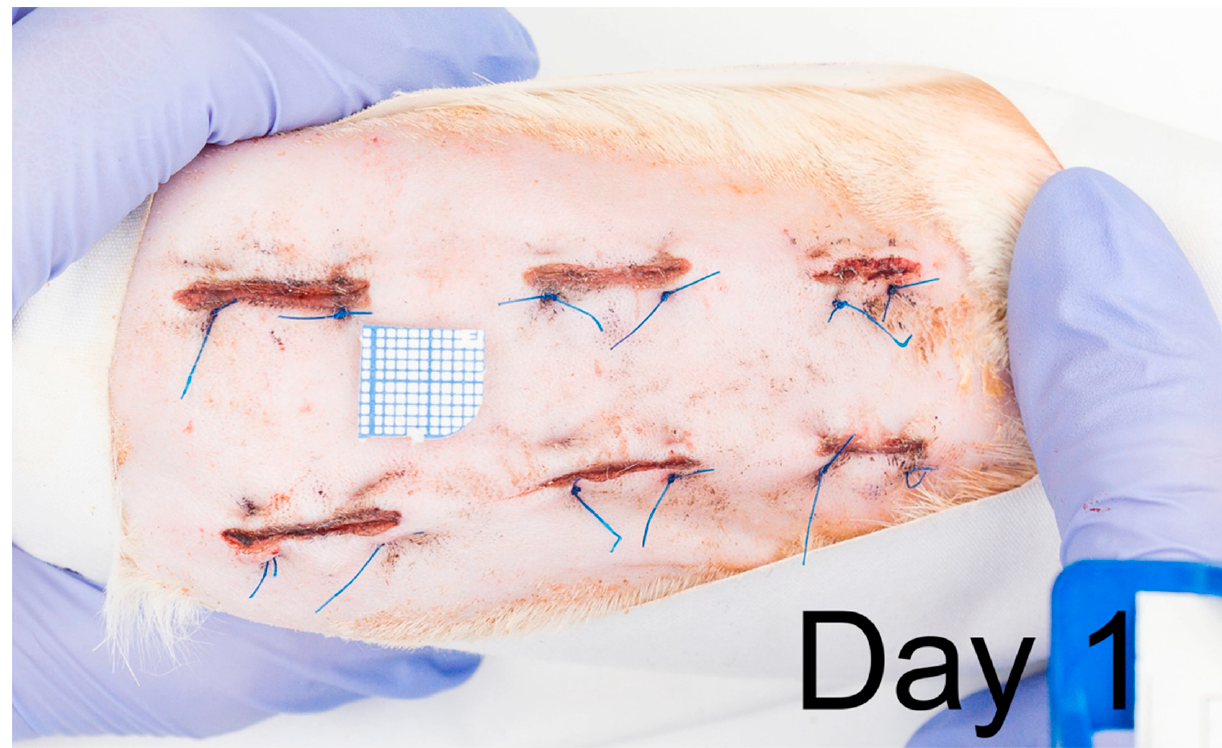
Figure 1. Video presents wound healing process captured with 11 time points of 60-days observation of a representative rat.